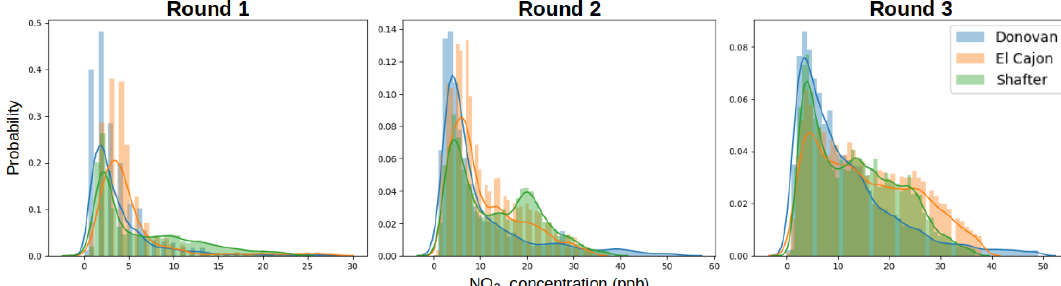
Figure A3. NO 2 distributions for each location, by round.